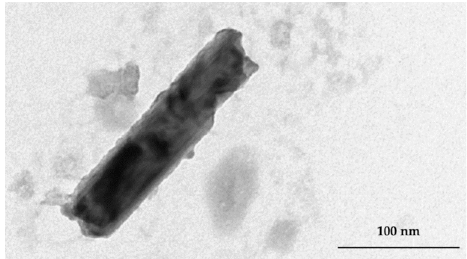
Figure 4. TEM image of PC–NCs re-suspended with distilled water after two months of storage at room temperature in the lyophilised state (scale 100 nm).